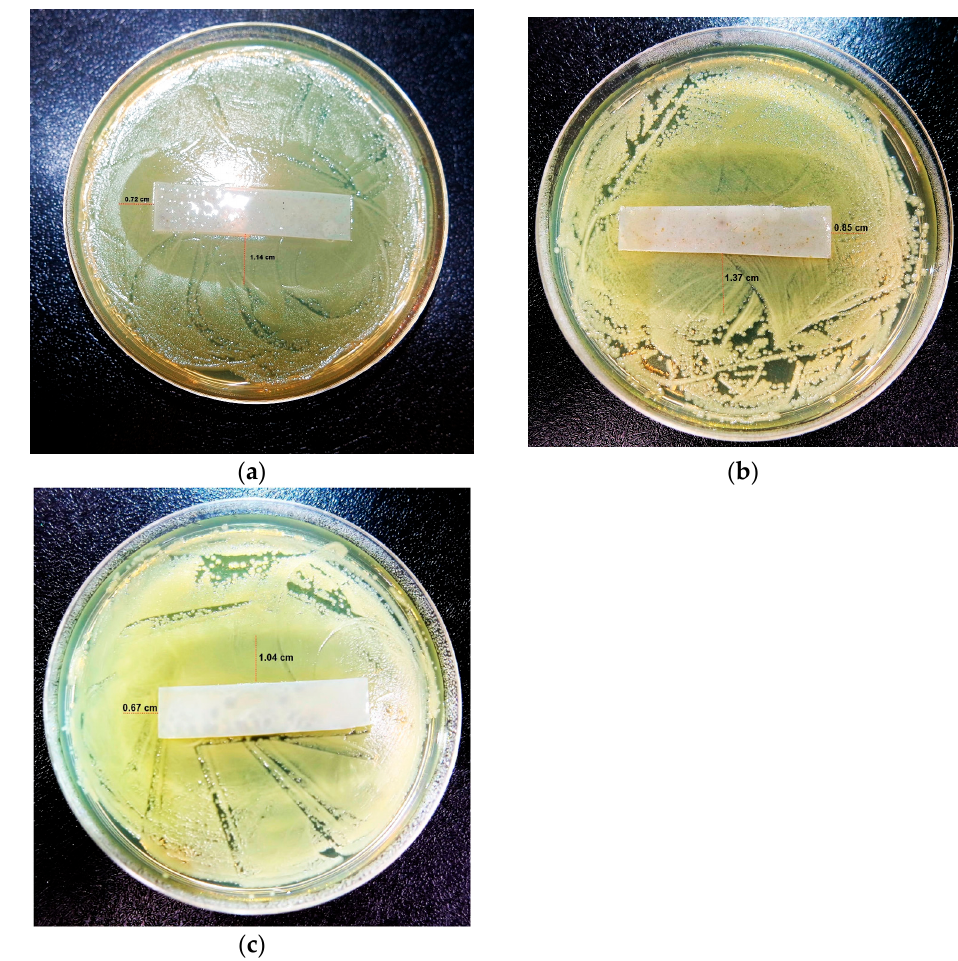
Figure 10. Antimicrobial efficacy tests of the starch-PEJP film against ( a ) Staphylococcus aureus ; ( b ) Escherichia coli ; and ( c ) Salmonella spp.